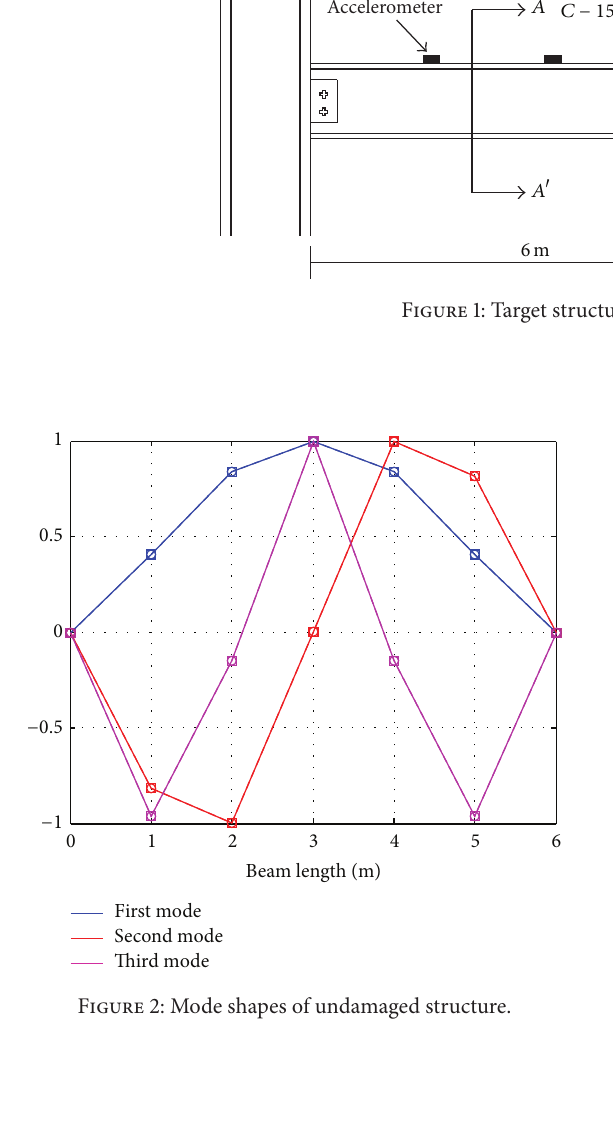
spring at damaged location. The springs on the right end of element 1 and left end of element 2 were assumed to have linear rotational stiffness values of 295.20 kN ⋅ m/rad and 147.60 kN ⋅ m/rad, respectively. These stiffness values represent the severity of damage.